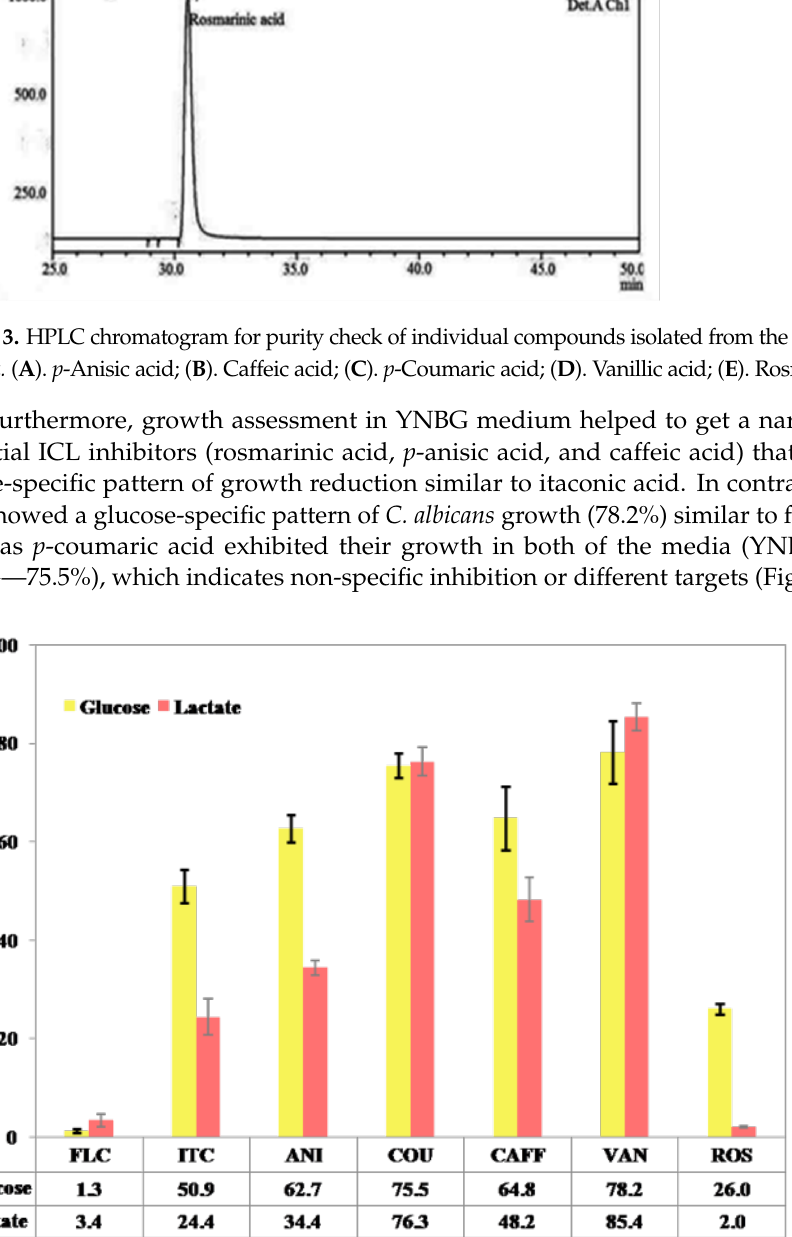
Figure 4. Alternative screening approach for C. albicans growth in YNB broth supplemented with glucose or lactate as sole carbon source. Error bar in the chart represents standard